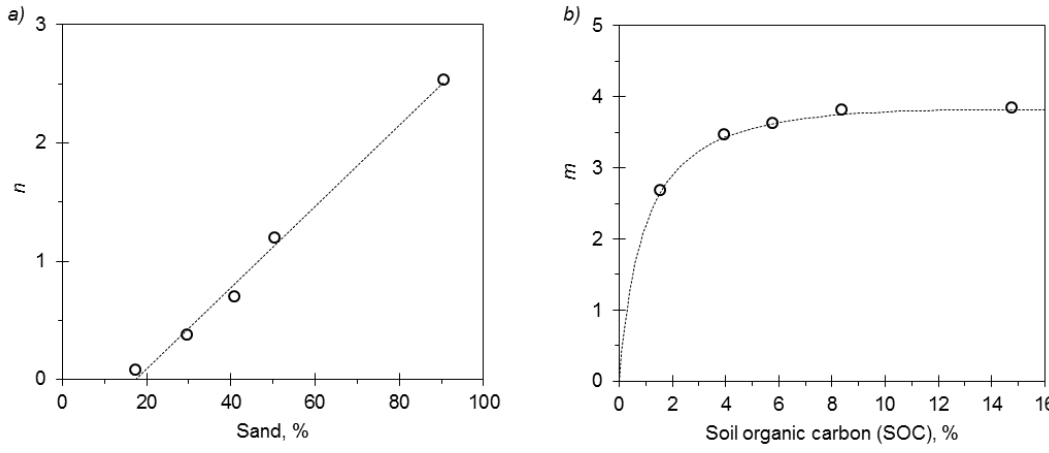
Figure 3. Archie model: relationships ( a ) n vs. sand content and ( b ) m vs. soil organic carbon. The dotted line represents the fit described by Equations (20) and (21), respectively. For the latter, RSS = 2.46 × 10 −3 and RMSE =